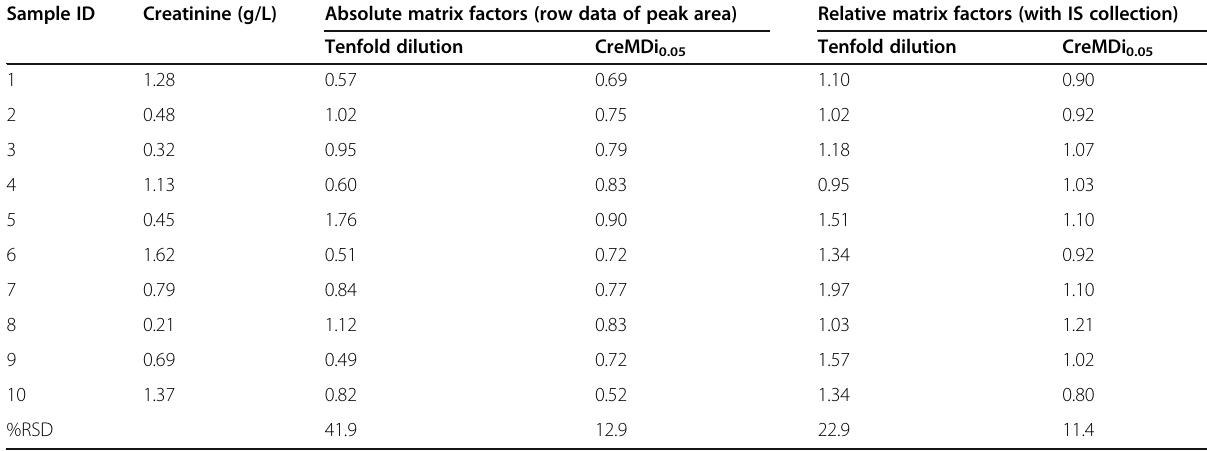
Table 3 Absolute and relative matrix factors of 10 individuals Sample